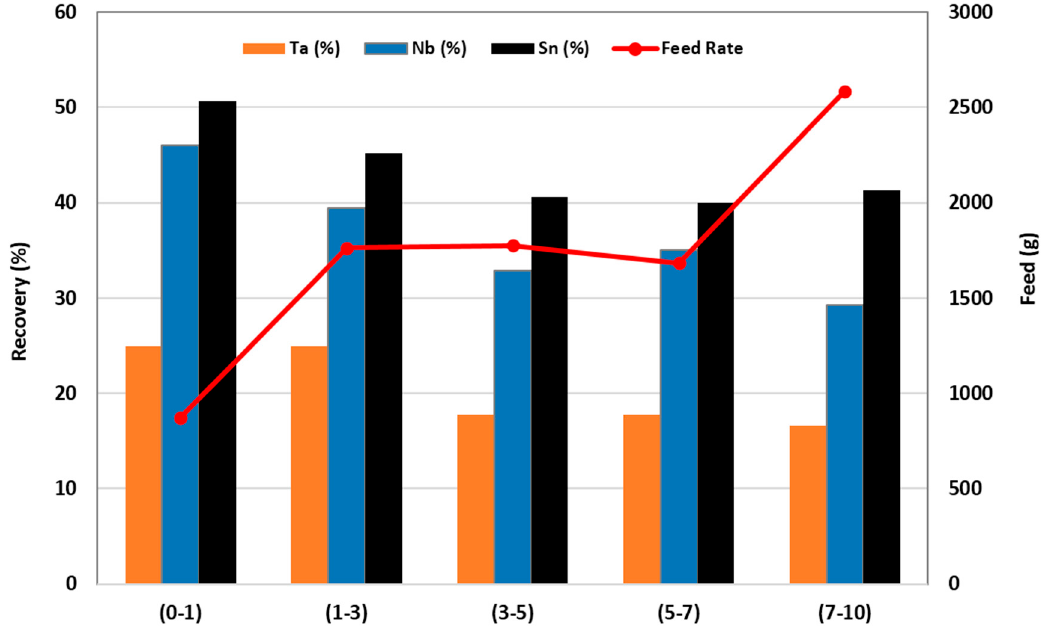
Figure 16. Plot of Ta, Sn and Nb recovery rates through time versus volume of feed measured using PXRF.